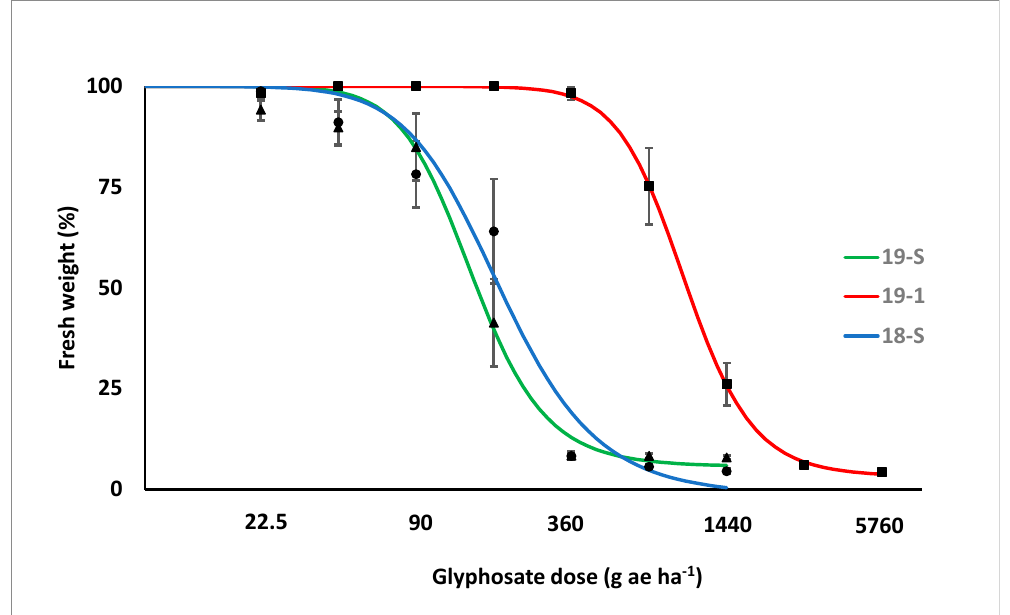
Figure 3. Fresh weight reduction response (expressed as % of the untreated control) to increasing glyphosate dose of the putative glyphosate-resistant (GR) biotype (19-1, red line) and the two susceptible reference biotypes (18-S and 19-S, blue and green lines, respectively). Values are the mean of the two experiments, i.e., six replicates. Bars represent standard errors.